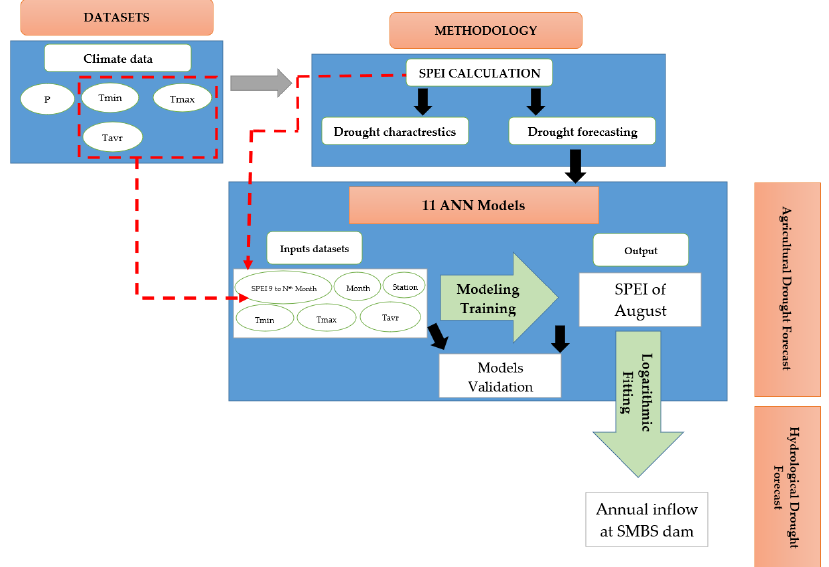
Figure 2. Architecture of ANN ML model.